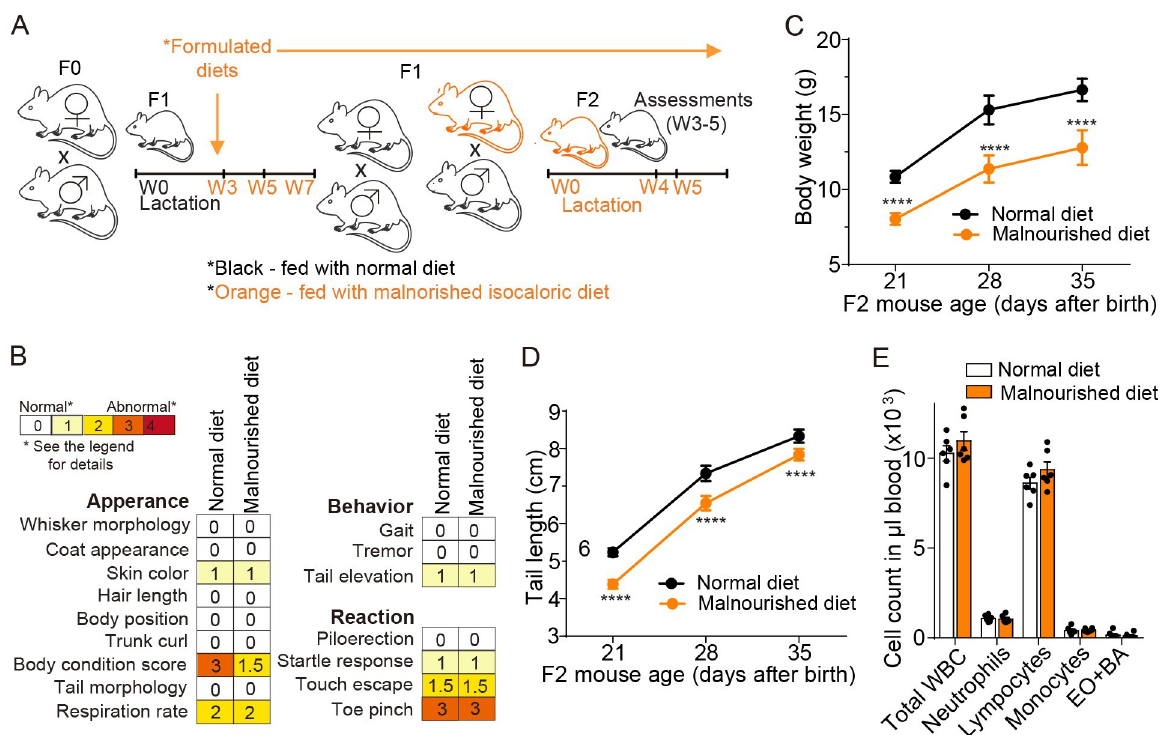
Fig 2. The establishment of a malnourished maternal vaccination model. A , Timelines of normal- and malnourished isocaloric diet-feeding and mating that were used in this study. Both F1 and F2 mice were fed normal and malnourished diets. See Table 1 for details. B , SHIRPAs on the 5 weeks-old F2 mice. See Table 2 for details. C , Bodyweight changes of normal and malnourished diet-fed F2 mice from week 3 to 5. D , Tail length changes of these F2 mice. E , Circulating leukocyte counts available in 1 μ l of peripheral blood of 5 weeks-old F2 mice. WBC, white blood cells. EO, eosinophils. BA, basophils. Lines and bars in C and D represent the mean ± standard deviation (SD), while the mean ± SEM is used for E. n = 13– 14 F2 mice per group for B-D. n = 6 F2 mice per group for E. ���� , p < 0.0001, relative to normal diet-fed F2 for C and D. Two-tailed unpaired t-